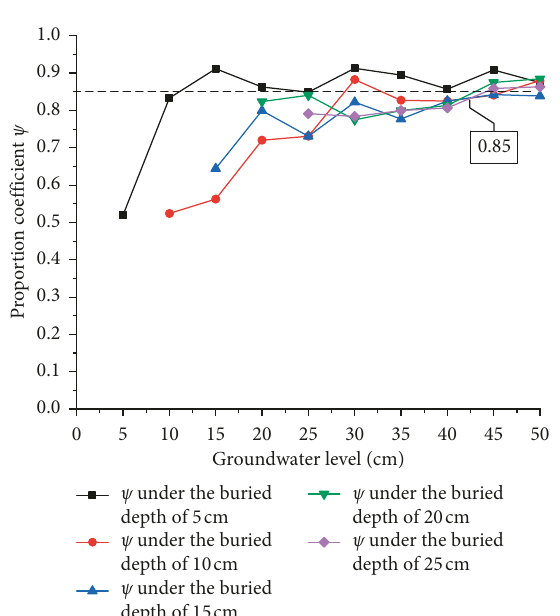
Figure 7: Variation of proportion coefficient Ψ with the groundwater level under different buried